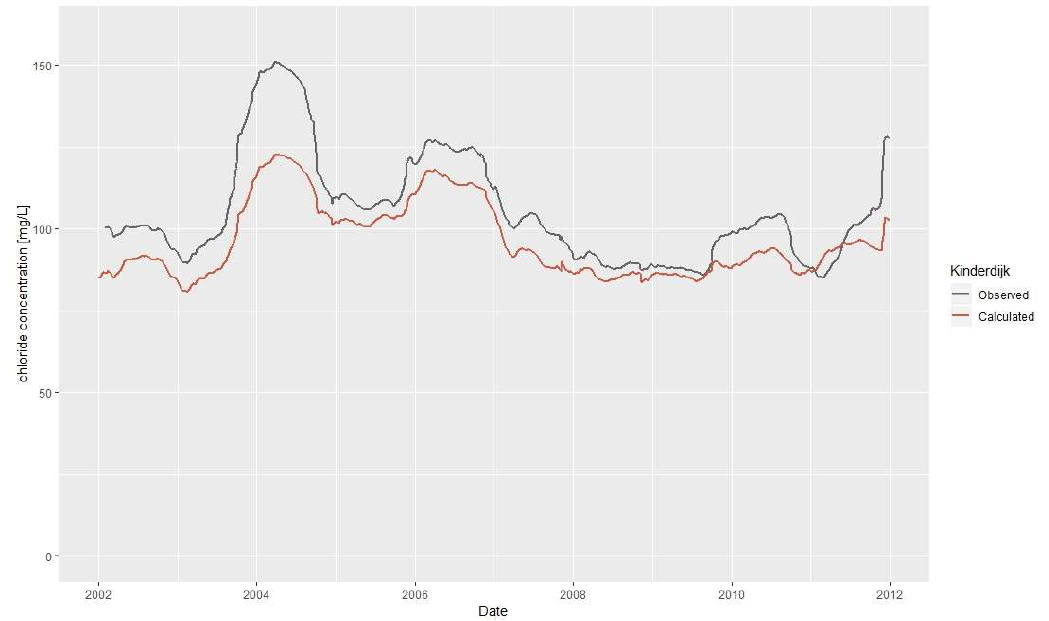
Figure 6. Comparison of the observed and modelled 365-day moving average chloride concentration at Kinderdijk. Please note that the moving average is tailing, that is, the salinization events occurring in the summer and autumn of 2003 start to have a noticeable effect on the MA in the second half of 2003 and remain visible until the second half of